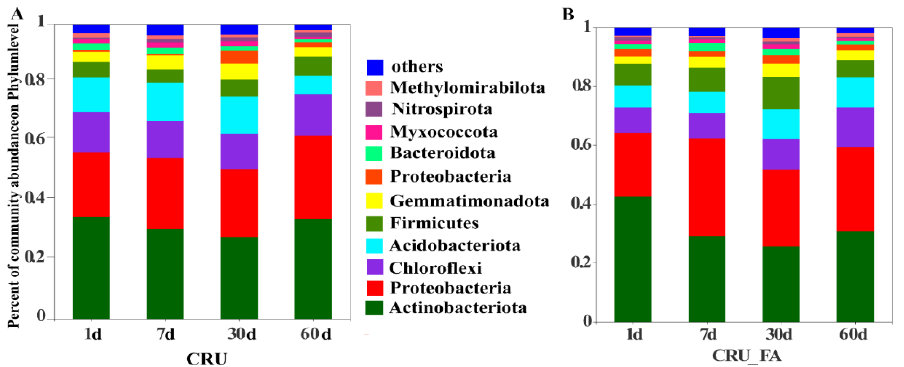
Figure 2. The treatment effects on relative abundance of soil bacteria community at the phylum level for CRU ( A ) and CRU+FA ( B ). Values reported are the means of three replicates.